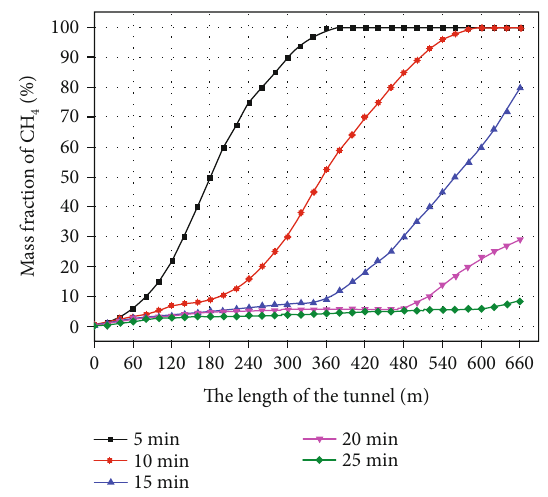
(m)0 The length of the tunnel Figure 9: CH concentration distribution in the tunnel (Case 4